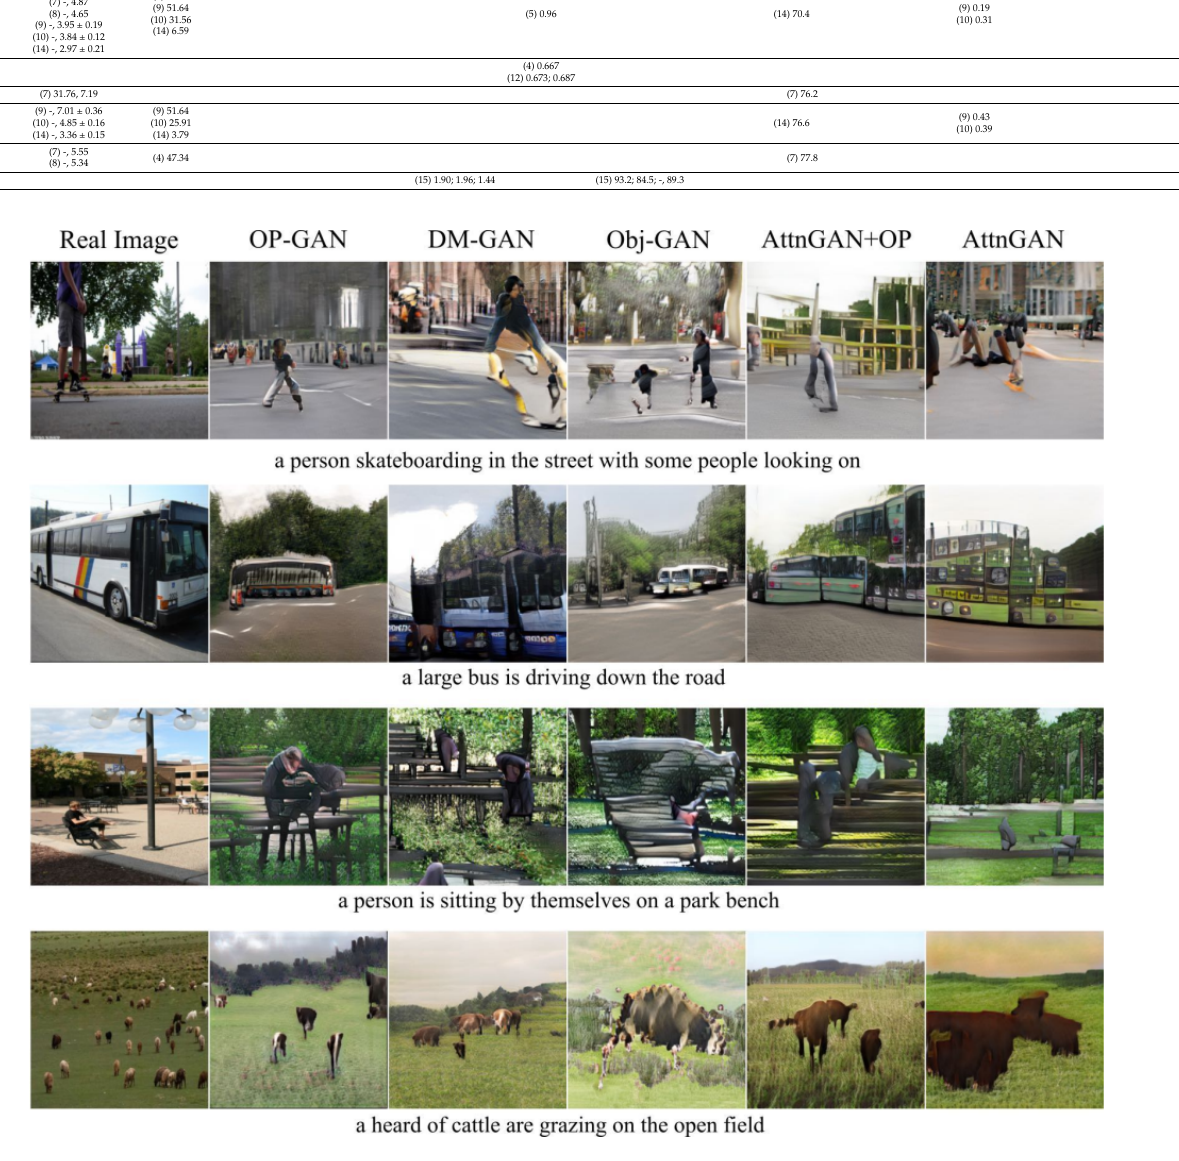
Figure 9. Examples reproduced from [177] using the COCO